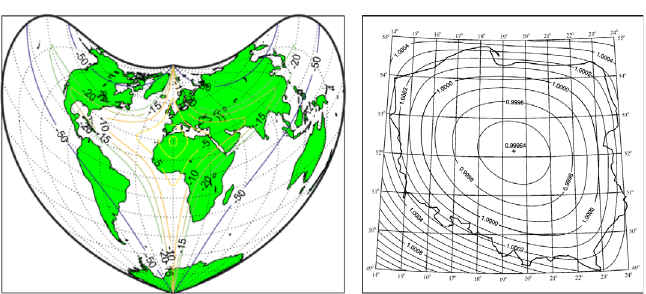
Fig. 6. The presentation of the distribution of distortions with the help of isolines of distortion (source: http:// www.mathworks.com/help/map/visualizing-and-quantifying-projection-distortions.html and P. Pędzich 2005)